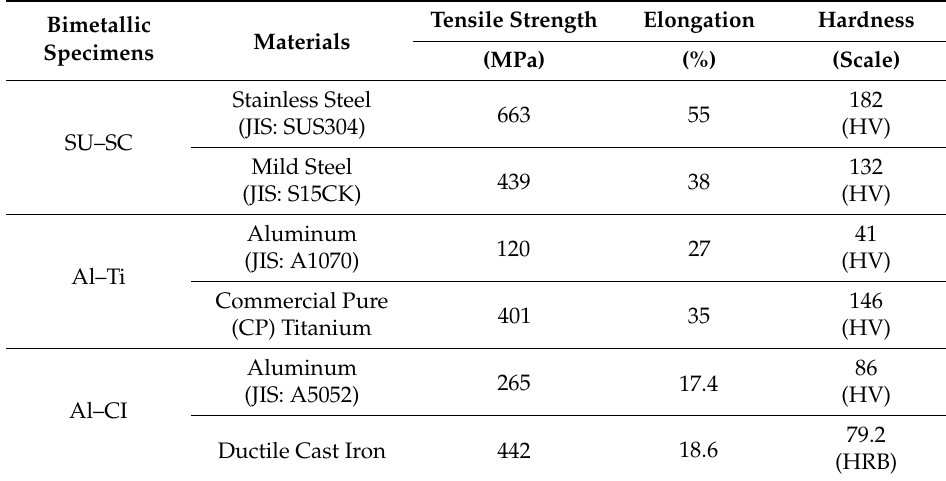
Table 1. Materials used for fabricating the dissimilar metallic